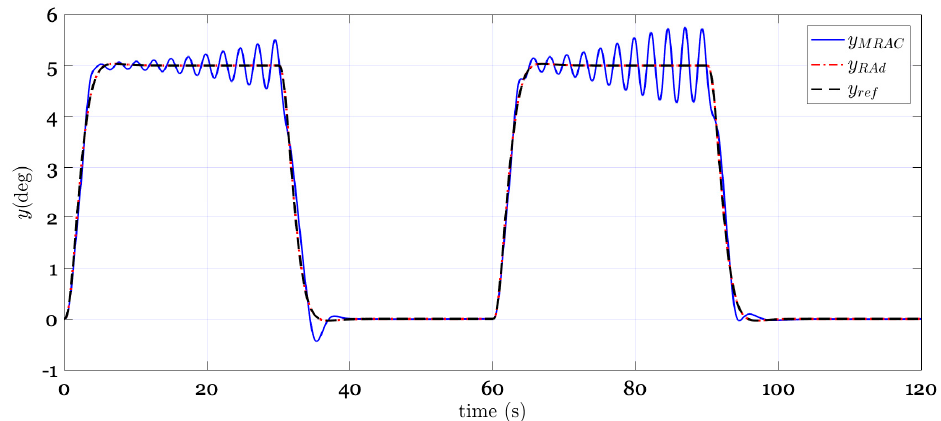
Figure 1. Tracking performance for model reference adaptive control (MRAC) and robust adaptive controller with 0.01 λ θ ρ ρ= = .